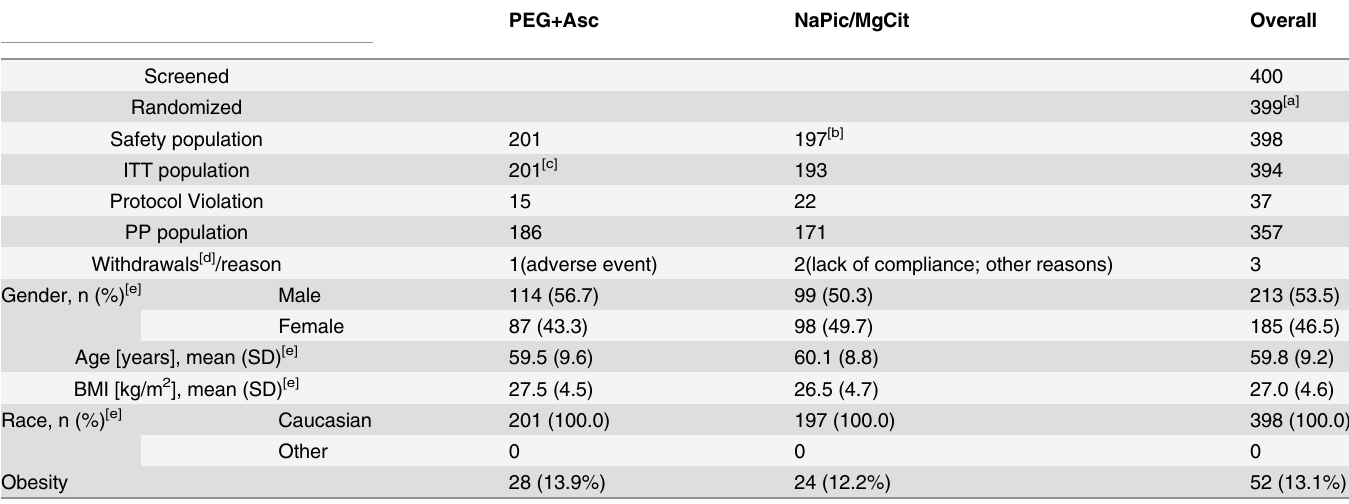
Table 1. Summary of Patient Demographics and Baseline